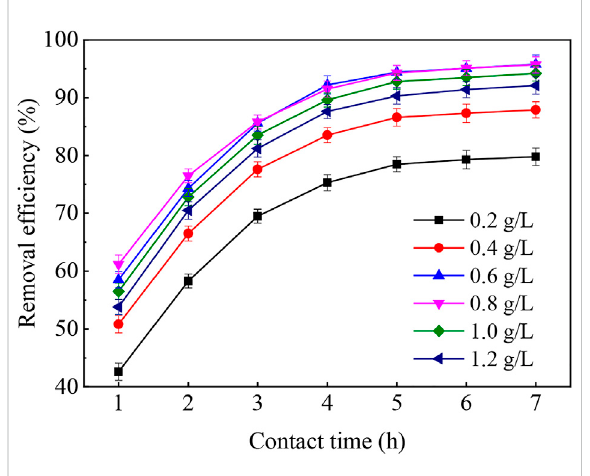
FIGURE 1 Phenanthrene removal from water under different wheat straw biochar dosages.